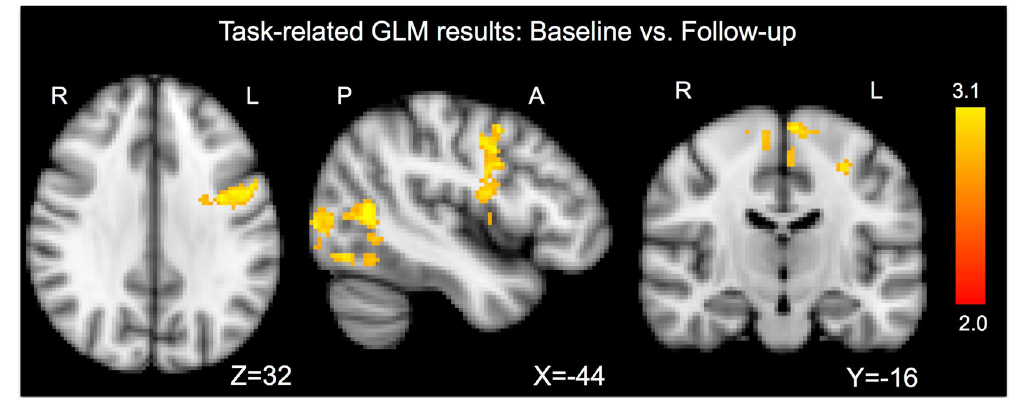
Figure 2. Task related GLM results.Task related GLM shows higher activation in Baseline vs. Follow-up for apprehension videos vs. control videos notably in the left motor and premotor cortex, somatosensory cortex, lateral occipital cortex, and para-hippocampal gyrus. Results show brain areas surviving TFCE correction. P values < 0.05 were considered as significant. No significant differences were found for the other